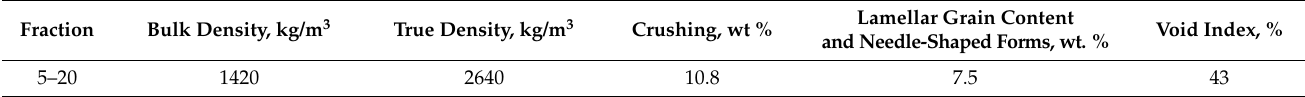
Table 4. Physical and mechanical characteristics of crushed granite.